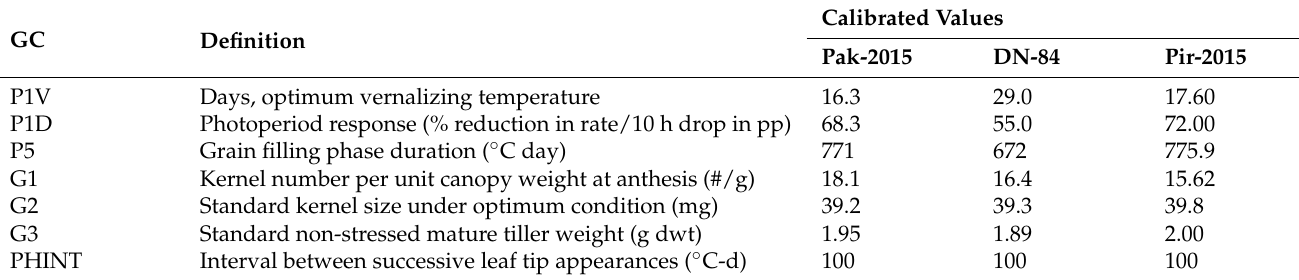
Table 2. Genetic coefficient best fit for the three wheat cultivars for seasons 2016–17 and